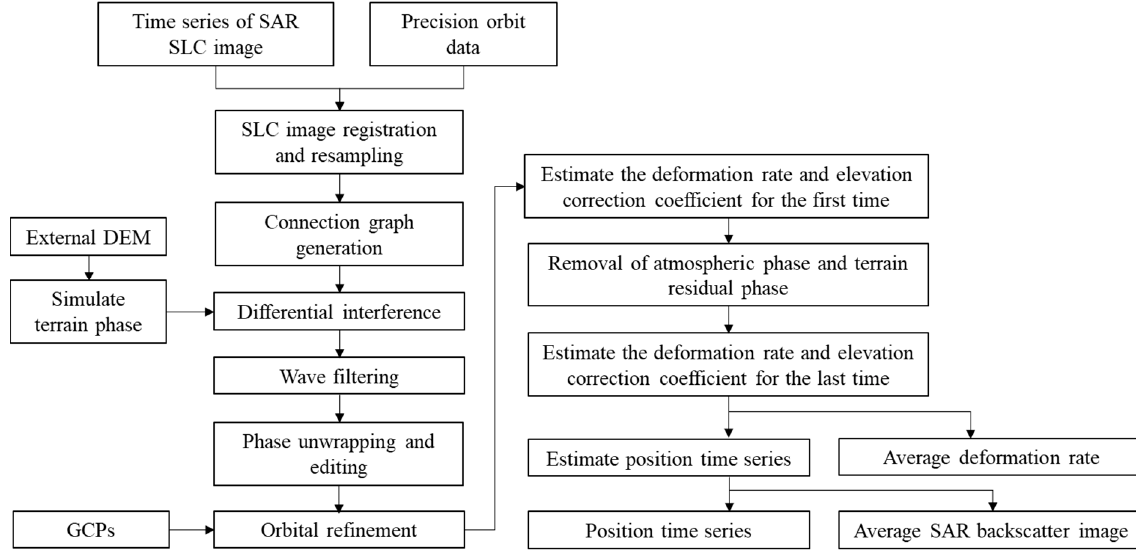
Figure 11. Flowchart of SBAS method.